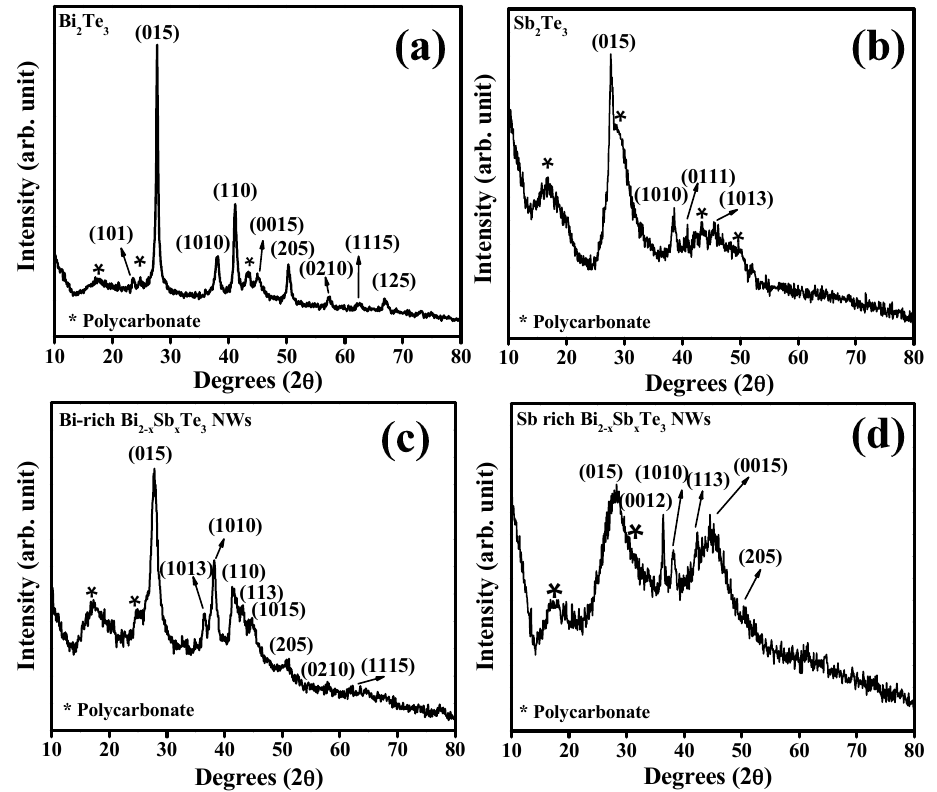
Figure 3. Representative XRD patterns of Bi 2- x Sb x Te 3 NWs of different nominal compositions; ( a ) for x = 0 i.e., pure Bi 2 Te 3 ( b ) for x = 2 i.e., Sb 2 Te 3 ( c ) Bi-rich and ( d ) Sb-rich Bi 2– x Sb x Te 3 NWs. The NWs show a noticeable peak broadening with increasing Sb, due to the grain size difference between the Bi-rich and Sb-rich compositions, showing polycrystalline signature for all of the types of